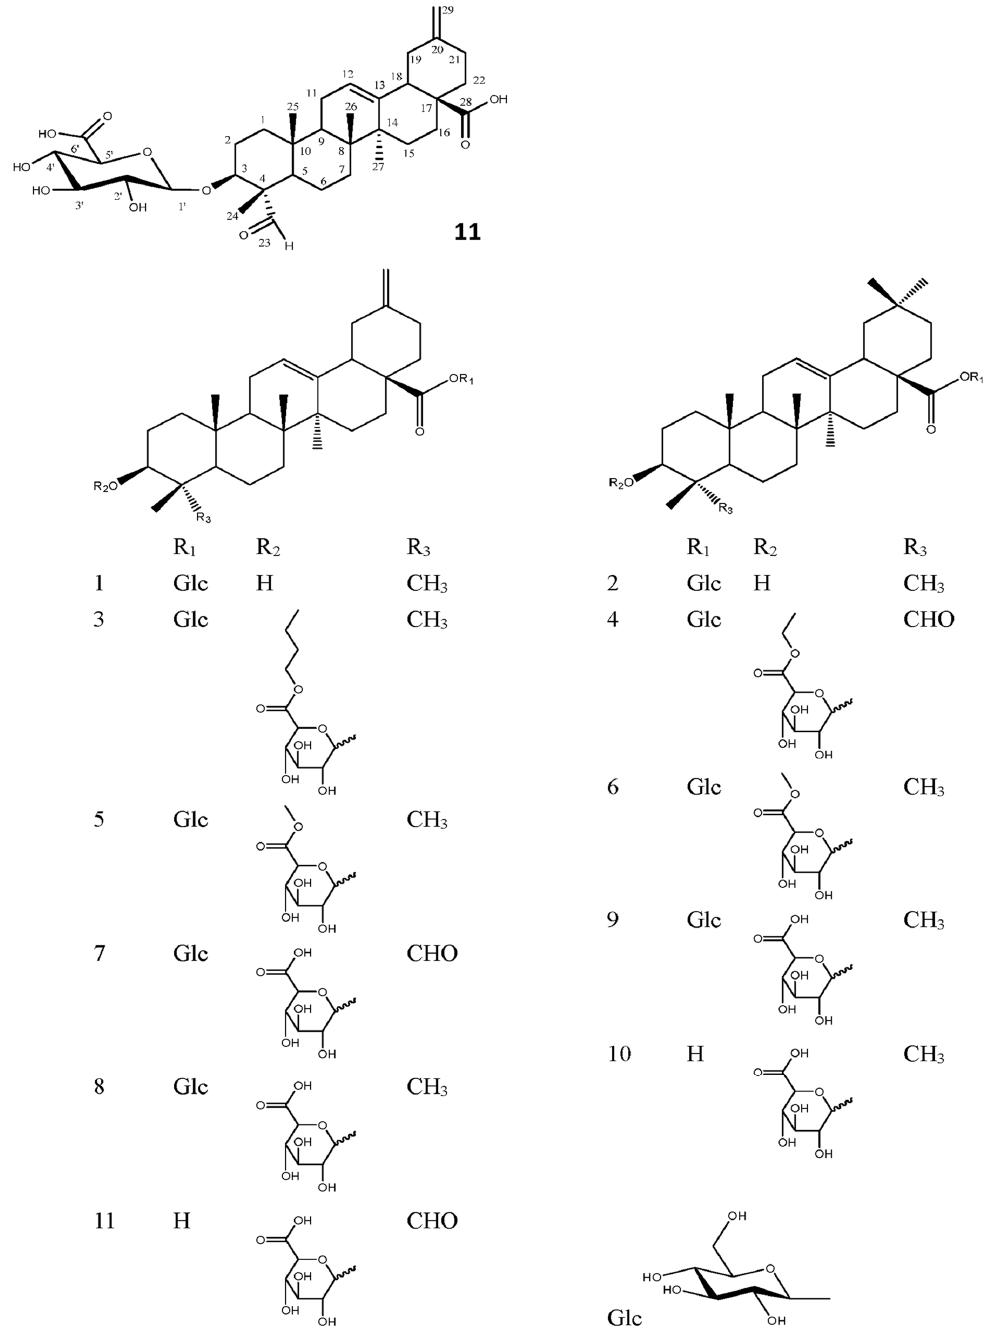
Figure 1. Structures of compounds 1 – 11 .